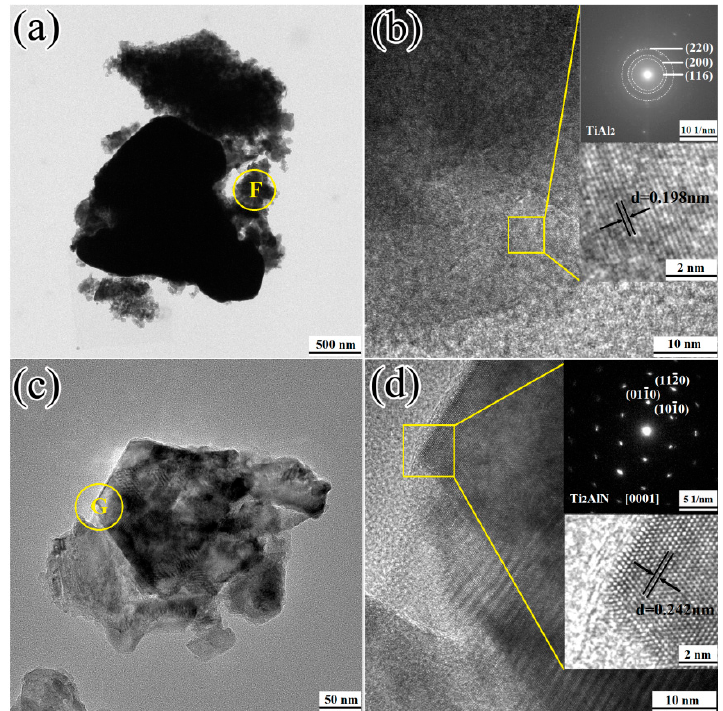
Figure 11. ( a ) TEM image; and ( b ) HRTEM image and electron di ff raction pattern of 1TiH 2 / 1.15Al / 1TiN after one minute of sintering at 720 ◦ C; ( c ) TEM image; and ( d ) HRTEM image and electron di ff raction pattern of 1TiH 2 / 1.15Al / 1TiN after 30 min of sintering at 1250 ◦ C.